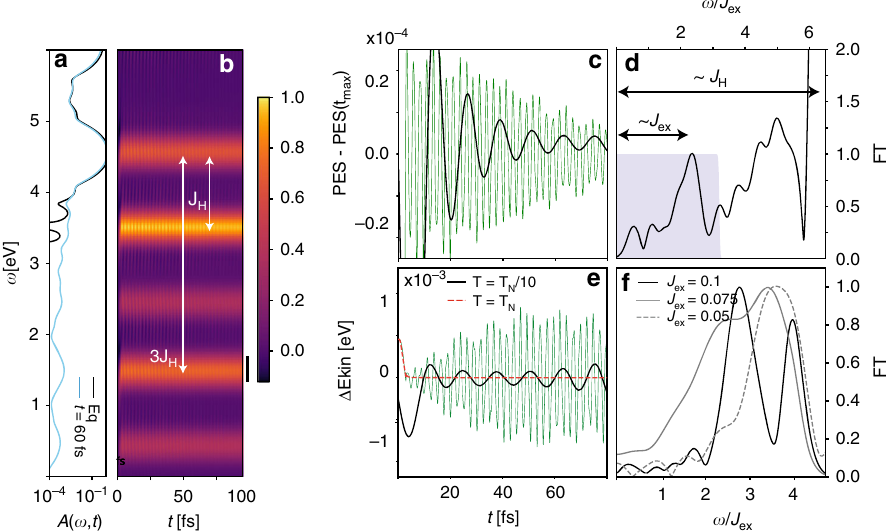
Fig. 4 Non-equilibrium DMFT calculations for a two-band t - J model. The parameters are t = 1 eV, J ex = 0.1 eV unless explicitly speci fi ed. a Spectral function A ( ω , t ) in equilibrium (black) and in the photoexcited state (light blue). b Theoretical time-dependent photoemission spectrum (PES), see Eq. (7), after the photoexcitation, exhibiting coherent oscillations of the photo-induced in-gap signal. c Time evolution of the energy-integrated PES in the window [1.3,1.6] eV, see also the vertical black bar in b . The thick black line shows a low-pass fi ltered signal corresponding to the limited temporal resolution in the experiment, while the thin green lines show the original data exhibiting superimposed rapid oscillations associated with Hund excitations. d Normalized Fourier transform of the energy-integrated PES signal exhibiting a low-energy peak scaling with the superexchange interaction J ex and a high-energy peak at an energy proportional to the Hund coupling J H . The gray shaded background corresponds to the employed low-pass fi lter. e Time evolution of the kinetic energy for a temperature below and equal to T N . The thin green line shows the original data and the thick black line the low-pass fi ltered data. f Fourier transform of the kinetic energy for different values of the superexchange interaction J ex = 0.05, 0.075, 0.1 eV. In all Fourier transform analyses, the background has been subtracted using a low-order spline